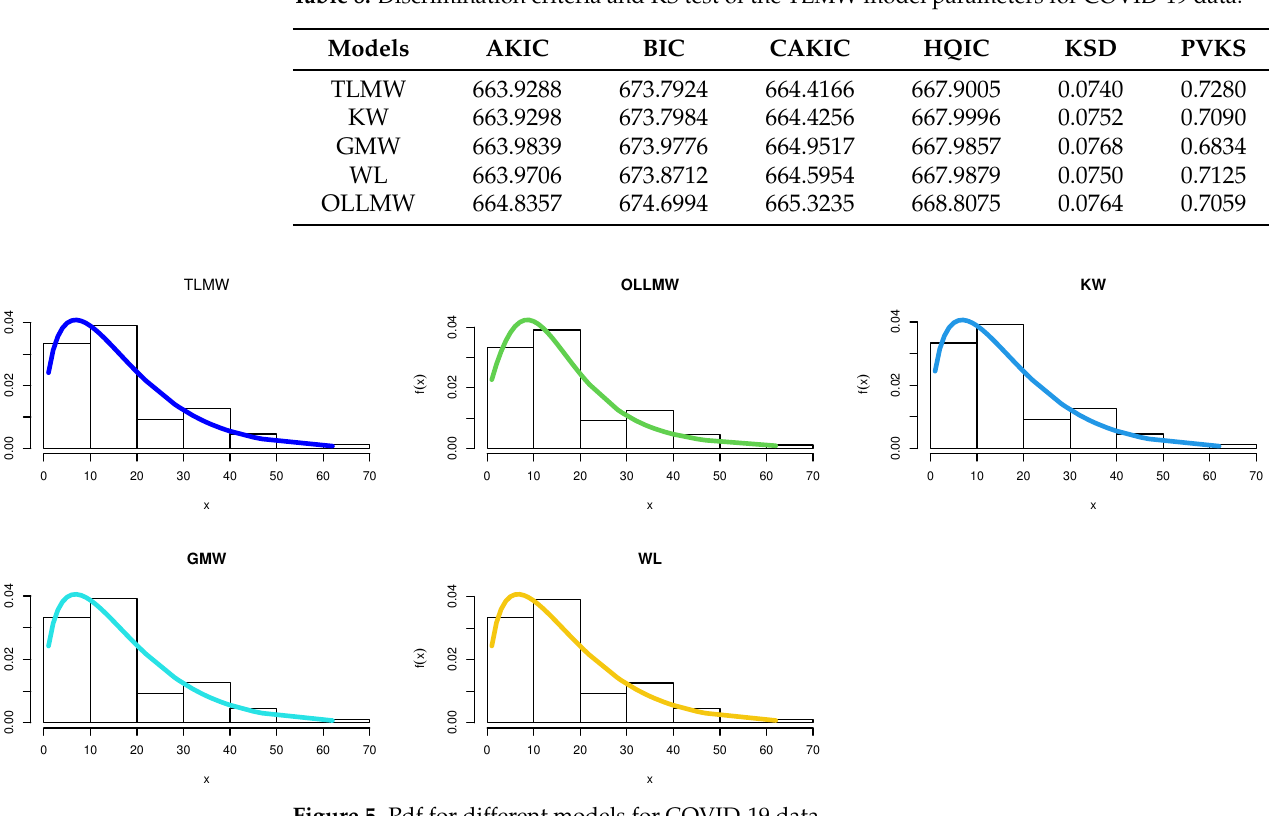
Figure 5. Pdf for different models for COVID-19